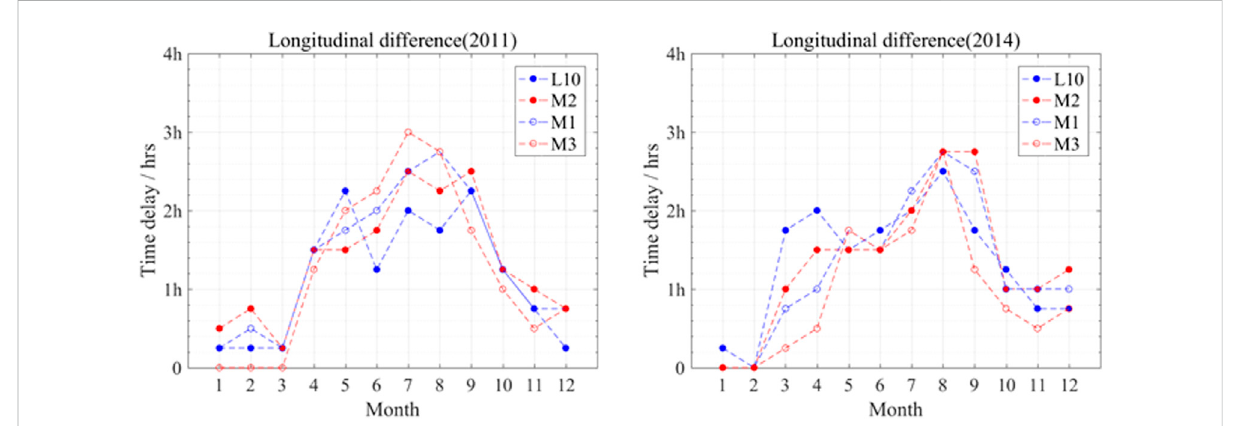
FIGURE 8 Comparison between stations at similar latitudes but different